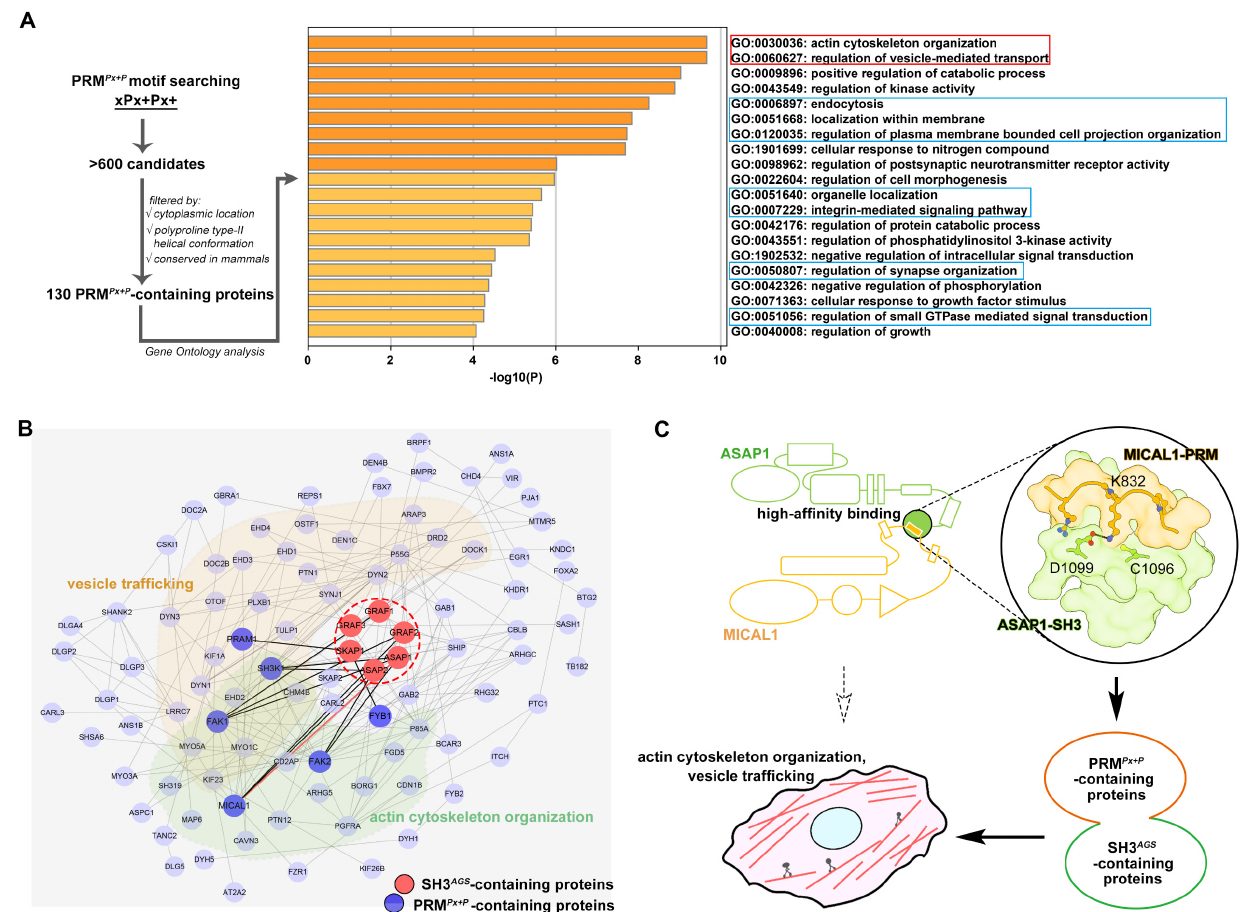
Figure 4. Functional implications of the high-affinity SH3 AGS /PRM Px+P recognitions. ( A ) Motif- searching to identify the PRM Px+P -containing proteins and the following Gene Ontology analysis. Two major functions were boxed in red, while other cellular membrane/cytoskeleton-related fields are boxed in blue. ( B ) A protein–protein interaction network among the SH3 AGS -containing ASAP/GRAF/SKAP proteins (red) and the PRM Px+P -containing proteins (blue). The known SH3 AGS binding partners were highlighted in dark blue. The targets involving vesicle trafficking and actin cytoskeleton organization are classified with a different color background. ( C ) A flow chart sum- marizing the identification of the high-affinity SH3 AGS /PRM Px+P recognitions and their potential physiological